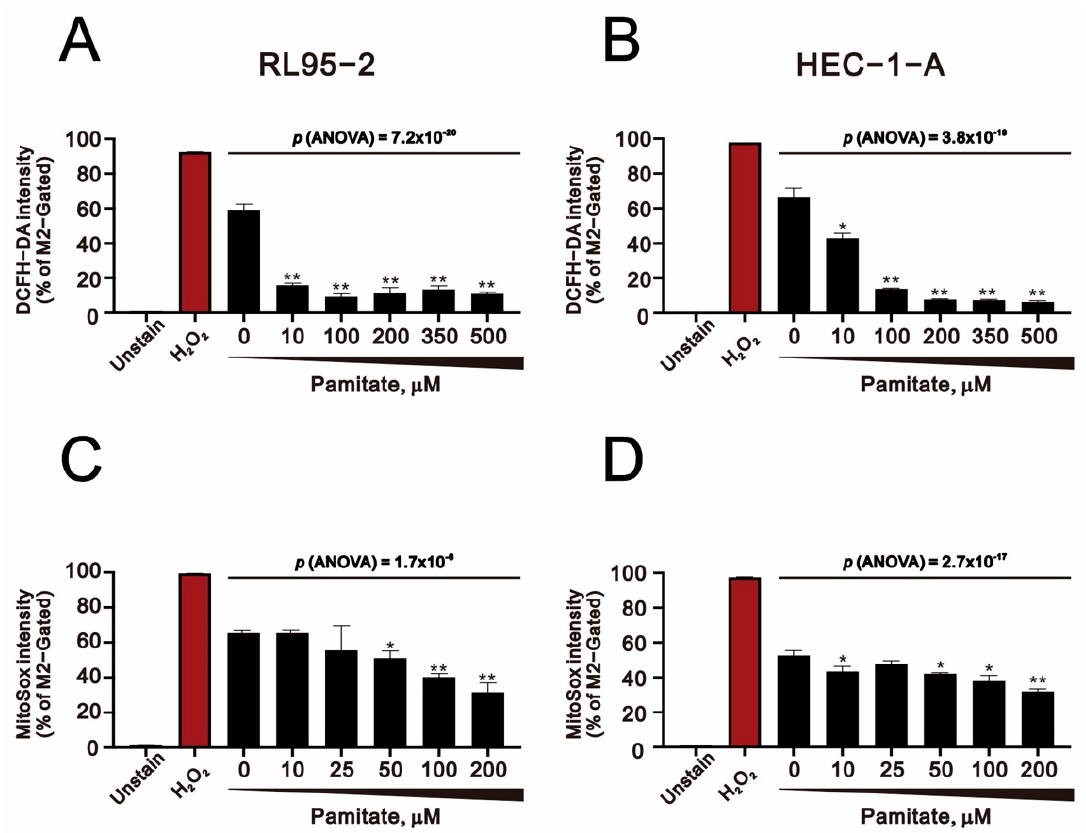
Figure 7. Effects of palmitate on ROS levels in human endometrial cancer cells. ( A ) RL95-2 and ( B ) HEC-1-A cells were incubated for 24 h, after which they were treated for 1.5 h with the indicated concentration of palmitate. Cellular ROS levels were monitored using 10 µ M DCFH-DA with flow cytometry. ( C ) RL95-2 and ( D ) HEC-1-A cells were incubated for 24 h, after which they were treated for 1.5 h with the indicated concentration of palmitate. Mitochondrial ROS levels were monitored using 5 µ M MitoSOX with flow cytometry. H 2 O 2 serves as a positive control in all panels. Bars depict the mean ± SD of three independent experiments. * p < 0.05, ** p < 0.01 (Student’s t -tests).